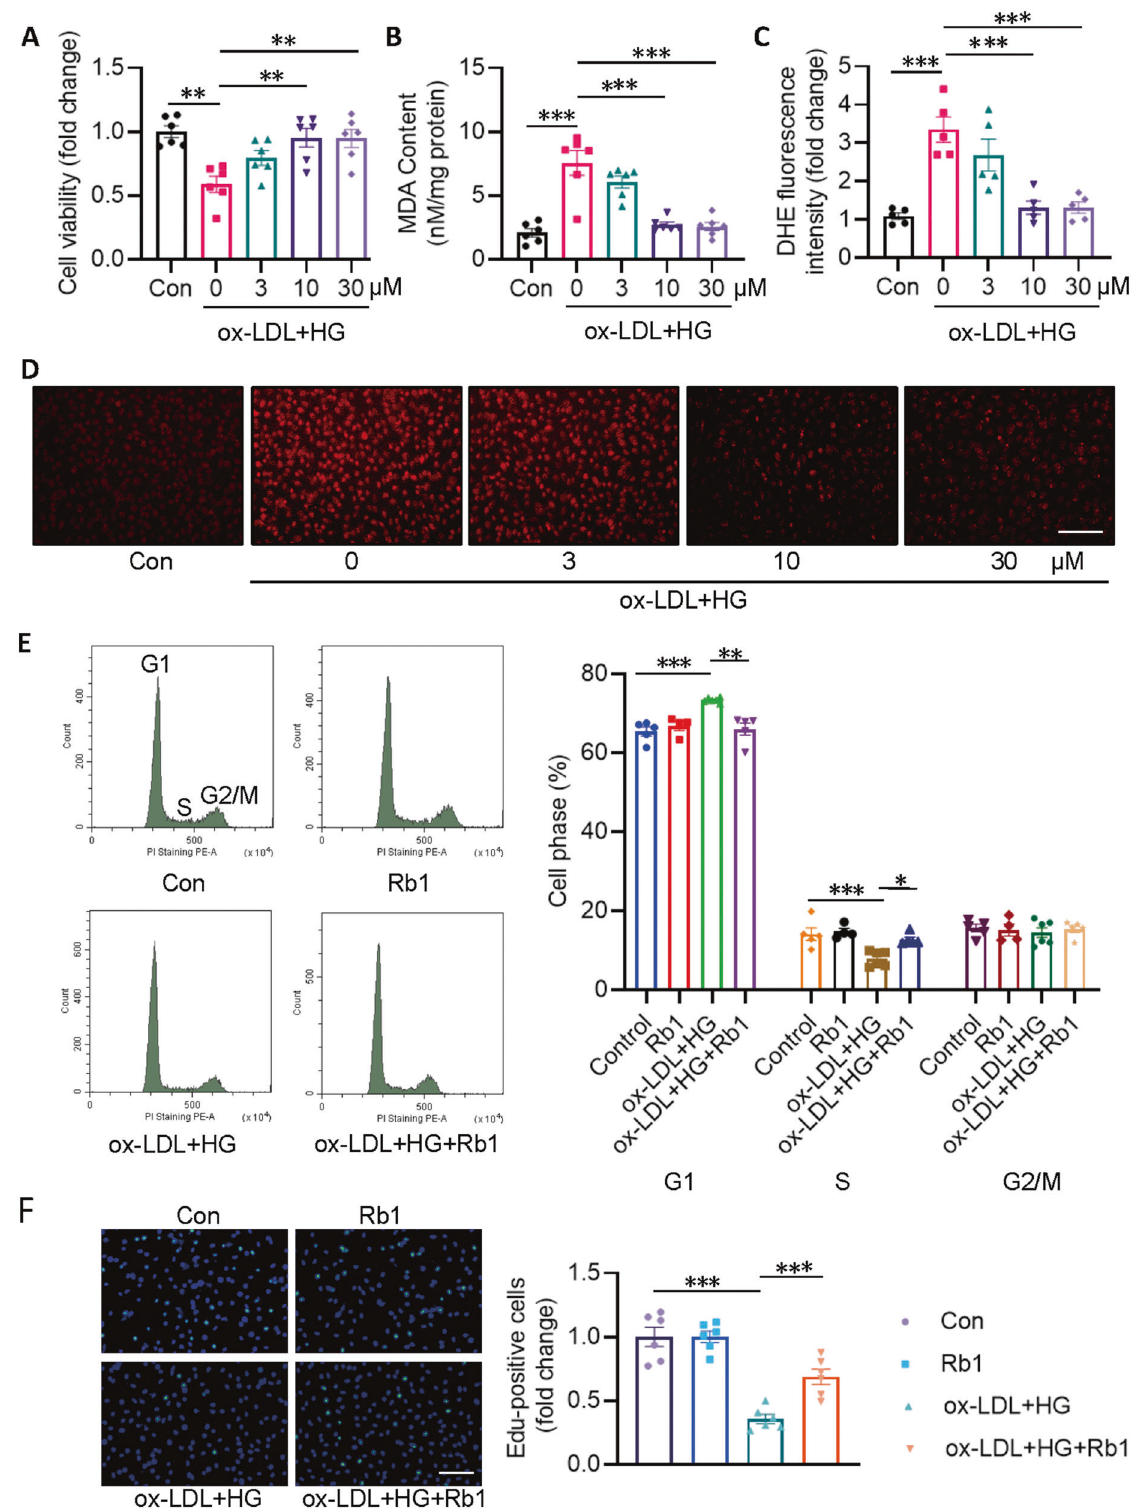
Fig. 1 Rb1 protects ECs from ox-LDL/HG-induced cell viability decline and oxidative stress. EA.hy926 ECs were pretreated with Rb1 (3, 10, and 30 μ M) for 30 min before ox-LDL/HG for 24 h. A Cell viability measured by CCK-8 assay. B MDA contents. C Quantitative analysis of DHE staining. D Representative images of DHE staining. Scale bar = 200 μ m. E Cell cycle was determined by fl ow cytometer and the cell cycle distribution was calculated. F EdU incorporation experiments and EdU-positive cells were quanti fi ed. Scale bar = 200 μ m. Data are presented as mean ± SEM. n = 4 – 6. Statistical analysis was performed with the randomized block ANOVA. * P < 0.05; ** P < 0.01; *** P < 0.001; vs . indicated group.